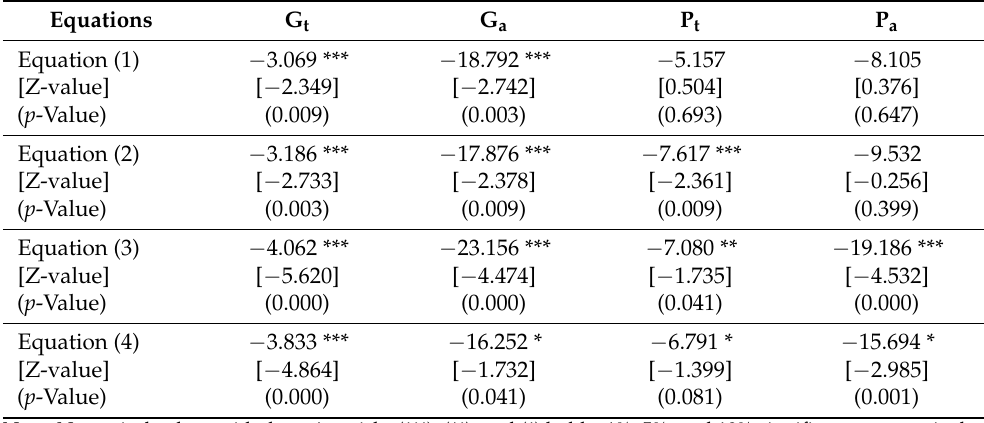
Table 5. Cointegration